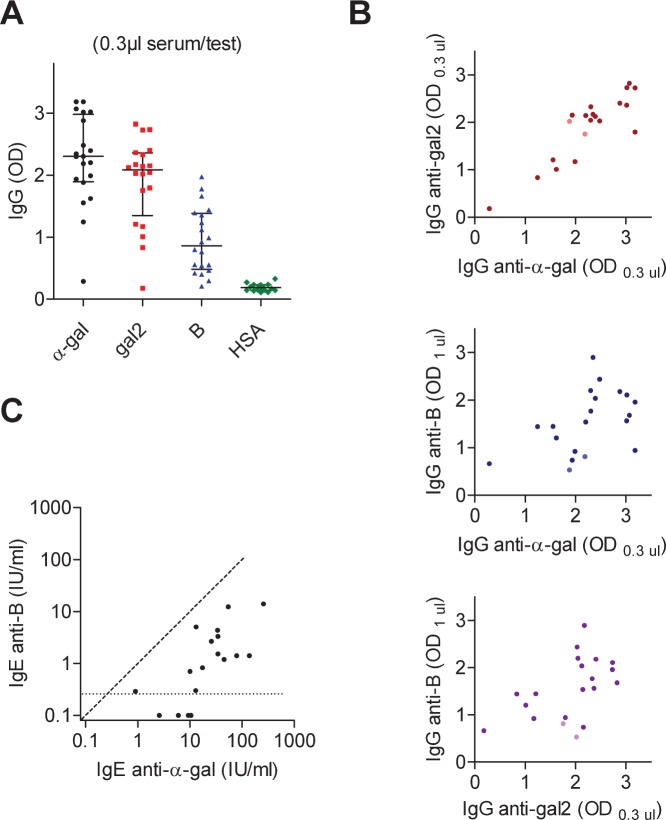
Correlations of IgG and IgE antibody responses in subjects positive for IgE anti-α-gal.A) IgG anti-α-gal, anti-gal2, and anti-B in IgE+ subjects (0.3 µl serum/test), including two B+ cases. B) Correlations between IgG anti-α-gal and IgG anti-gal2 (Spearman r = 0.76; p<0.0001), IgG anti-α-gal and IgG anti-B (r = 0.48; p = 0.048), and IgG anti-gal2 and IgG anti-B (r = 0.53; p = 0.021). Light-colored dots correspond to B+ subjects. C) IgE anti-α-gal and anti-B measured in IgE radioimmunoassay. Median responses were 21.7 (IQR 9.9–47.5) IU/ml for IgE anti-α-gal, and 1.3 (IQR 0.3–3.6) IU/ml for IgE anti-B, which is significantly lower (p<0.0001). Levels are nevertheless correlated (r = 0.76; p = 0.0003).